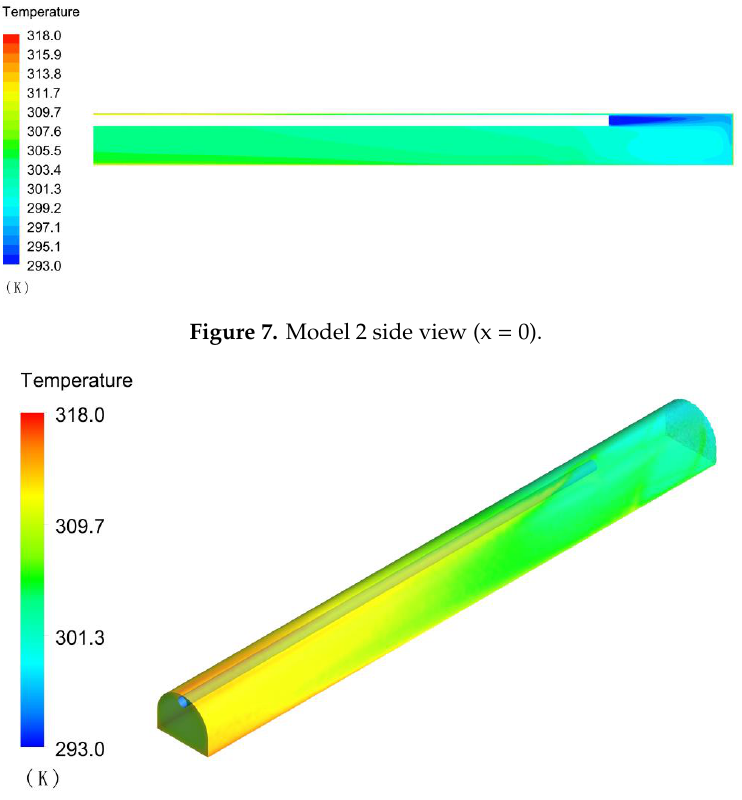
Figure 8. Three-dimensional distribution of Model 2 roadway temperature.